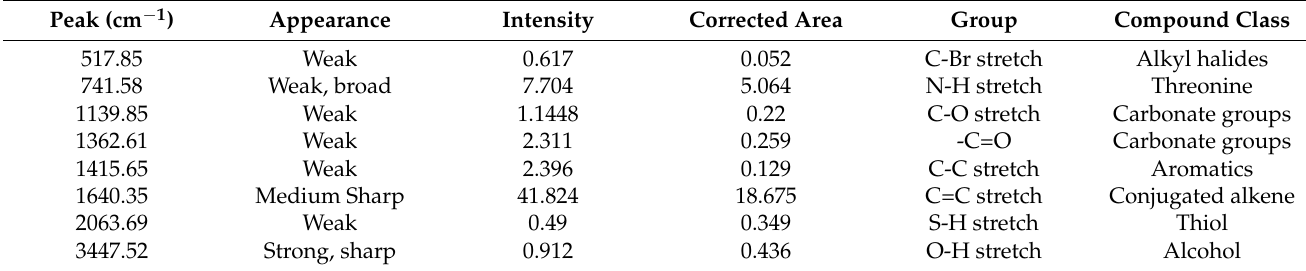
Table 6. FT-IR analyses of spittlebug P. costalis